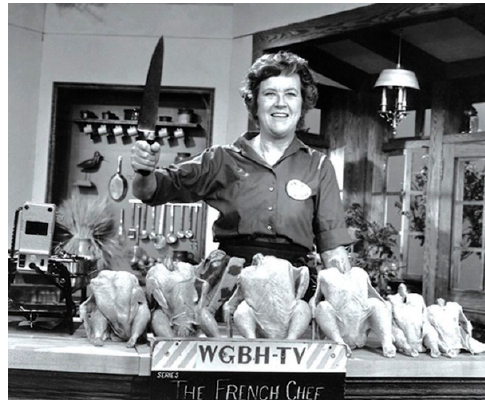
Figure 8. Julia Child in The French Chef on WGBH, 1963–66. Photo: Paul Child/PBS television, New York, USA.